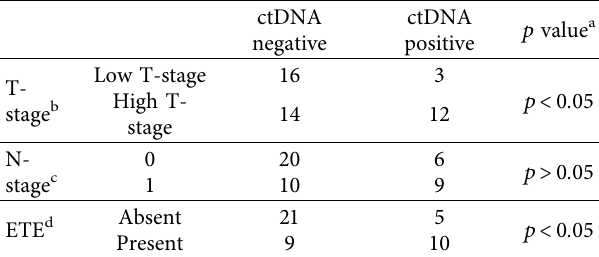
Table 2: Correlation of BRAF (V600E) ctDNA and T-stage, N- stage, and ETE.